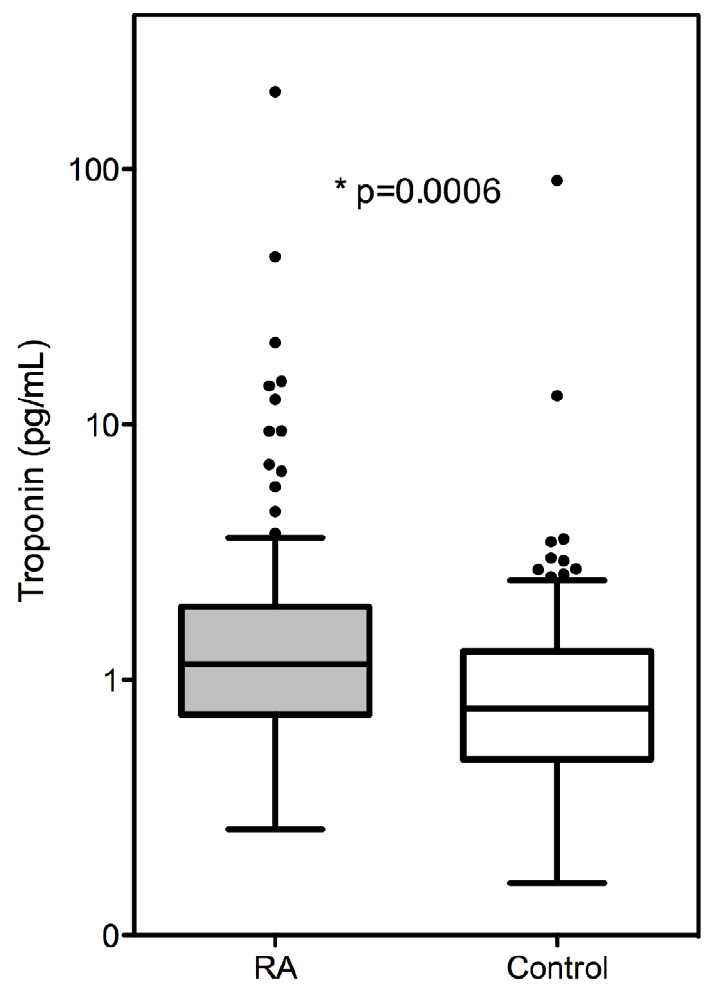
Figure 1. Unadjusted Troponin Concentrations. Boxplot of troponin concentrations (pg/mL) for RA subjects and controls, demonstrating elevated troponin concentrations in RA patients compared to controls (p=0.0006). Presented as 25th quartile, median, 75th quartile. Fences drawn to nearest value not exceeding 1.5 interquartile range. Observations beyond fences are plotted.